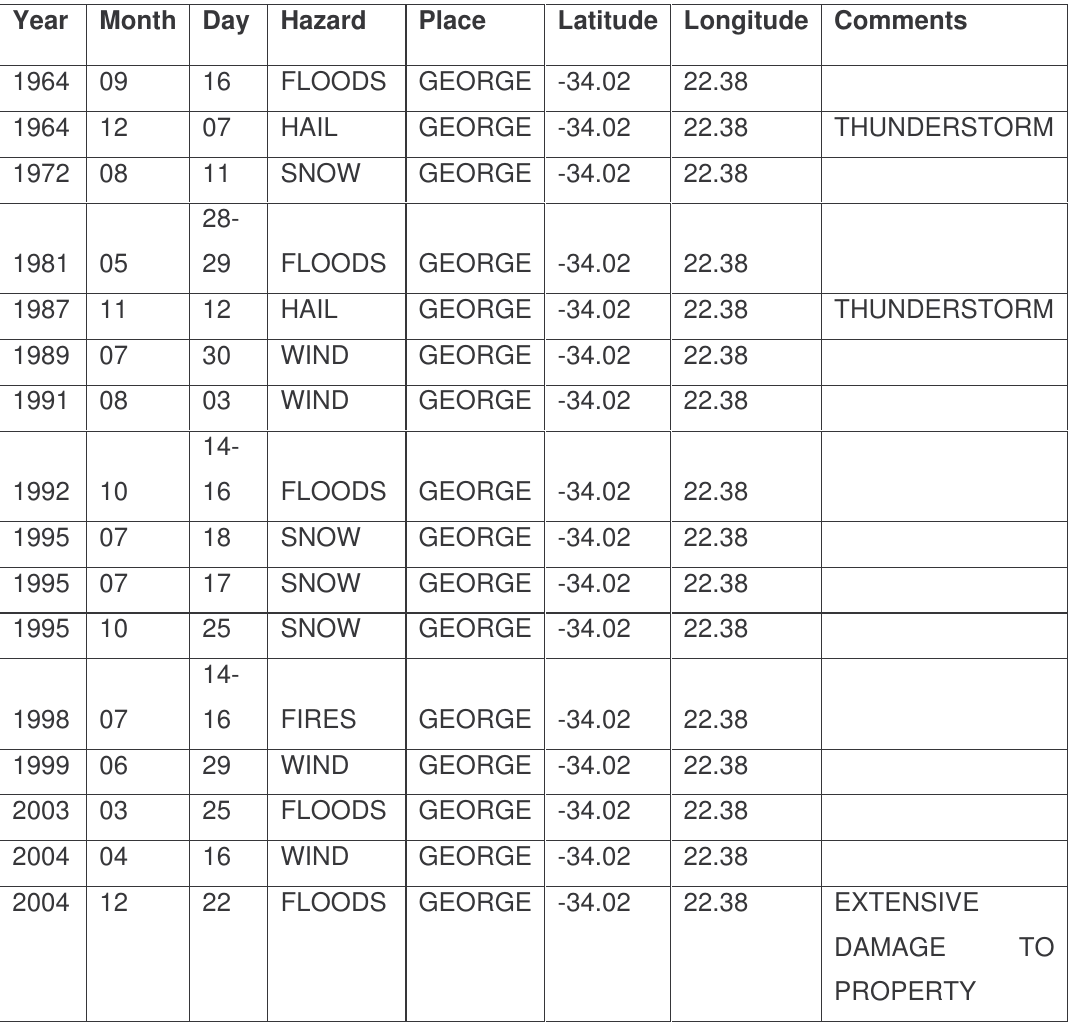
Table 1: List of events captured for George between 1964 and 2004 Source: Caelum database,